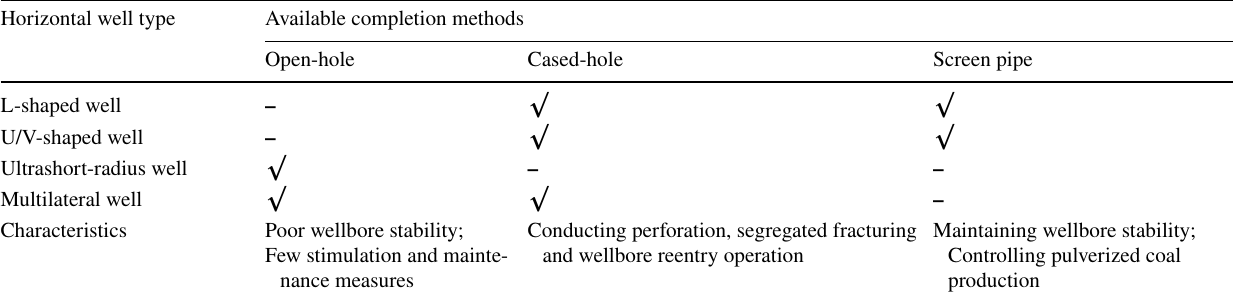
Horizontal well